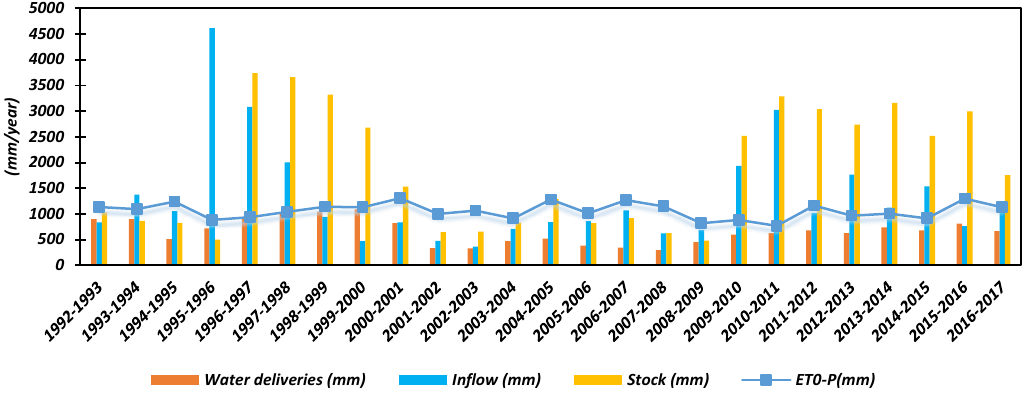
Figure 4. Annual values of atmospheric water demand ET 0 -P, water deliveries (W d ), inflow, and stock; Doukkala scheme, 1992–2017.